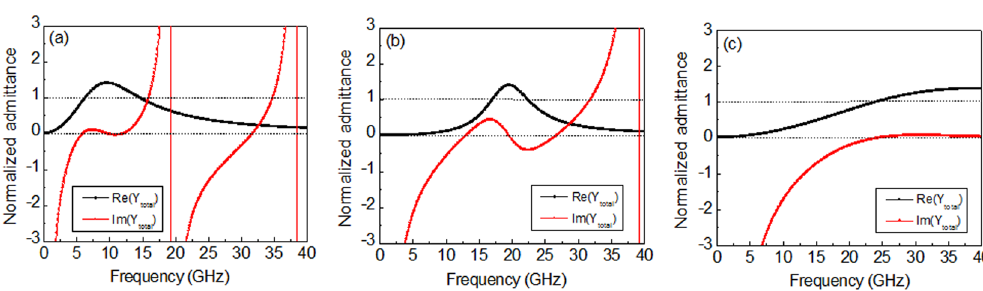
Figure 3. Normalized total admittance (Y total /Y 0 ) of the grounded air substrate with FSSs: ( a ) SL-FSS ( R s = 20 Ω/sq, t = 7.8 mm), ( b ) C-FSS ( R s = 10 Ω/sq, t = 3.8 mm), and ( c ) SP-FSS ( R s = 100 Ω/sq, t = 2.0